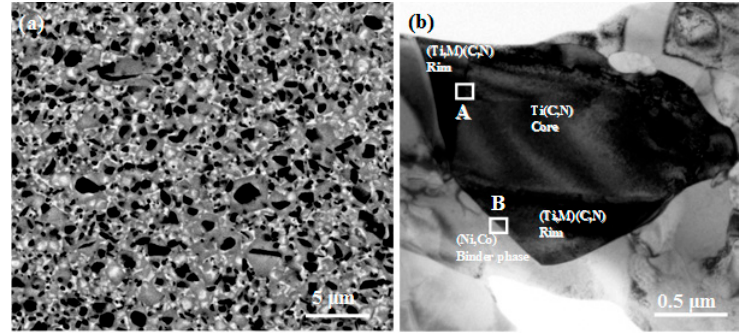
Figure 1. SEM micrographs ( a ) and TEM observation ( b ) of the microstructure in Ti(C,N)-based cermets prepared by solid phase reaction and liquid phase sinter-HIP.